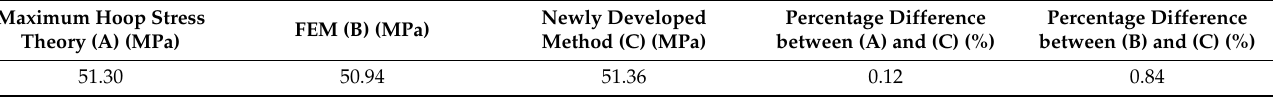
Table 8. Comparison of the intact pressure values of the pristine pipe.